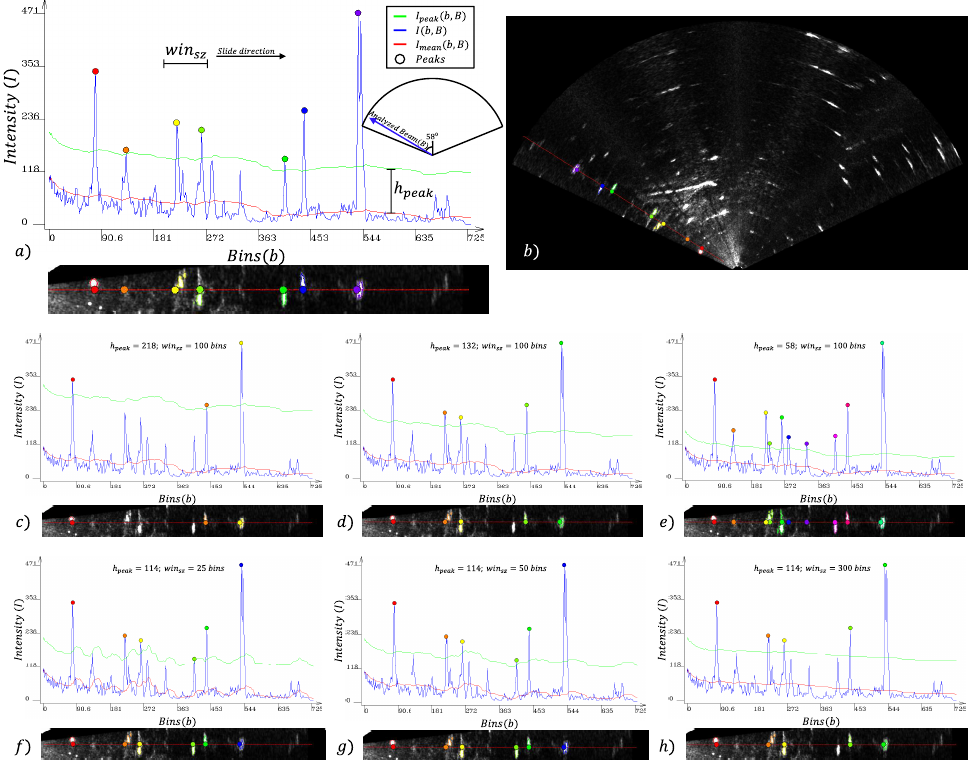
Figure 4. Local tuning parameters for segmentation. The graph represents the analysis of one acoustic beam B ( θ bin = 123 o ). In this analysis, the peaks of intensity are detected and used to locally adjust the segmentation parameters. The blue line represents the bins’ intensities I ( b , B ) ; the red line represents the mean intensities I mean ( b , B ) , and the green line represents the minimum intensity for peak detection I peak ( b , B ) . The colored circles represent the detected peaks. As can be seen in ( b ), each segment is extracted based on the intensity and position of the detected peaks in ( a ). The behavior of I peak calculated by Equations (1) and (2) can be observed in ( c – e ) when the parameter h peak is changed and in ( f – h ) when the parameter win sz is changed.